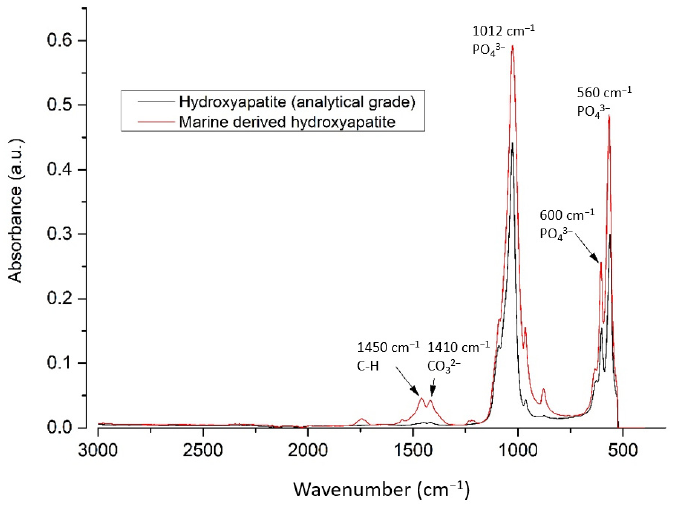
Figure 3. Spectra of analytical grade HAp and md-HAp showed a high degree of concordance.